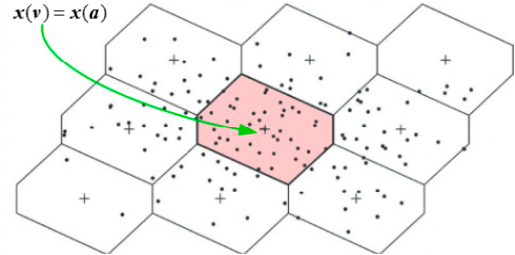
Figure 1. Illustration of the Voronoi cell in 2D.